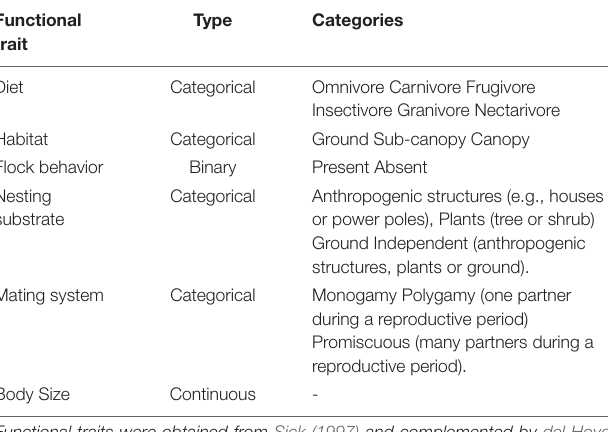
TABLE 1 | Functional traits of 107 bird species sampled by Souza et al. (2019) in Campo Grande that were used in this study. Functional